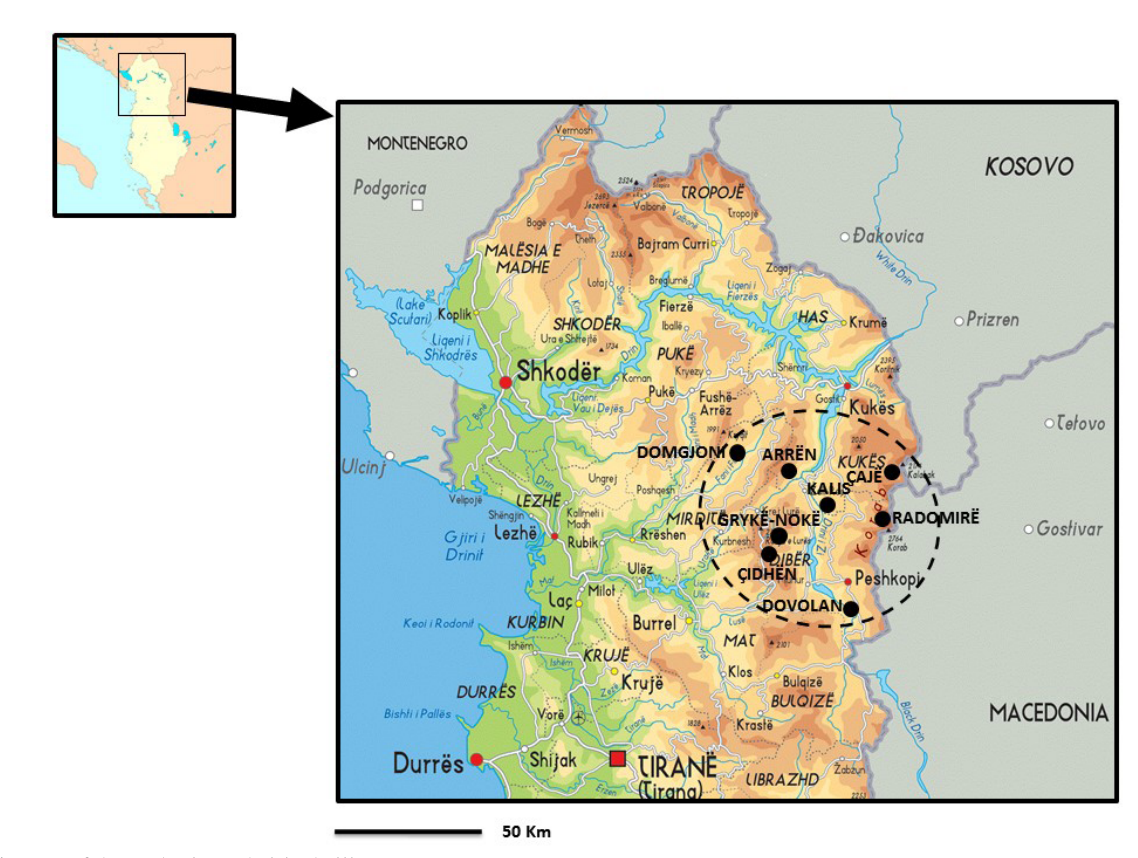
Fig. 1: Map of the study site and visited